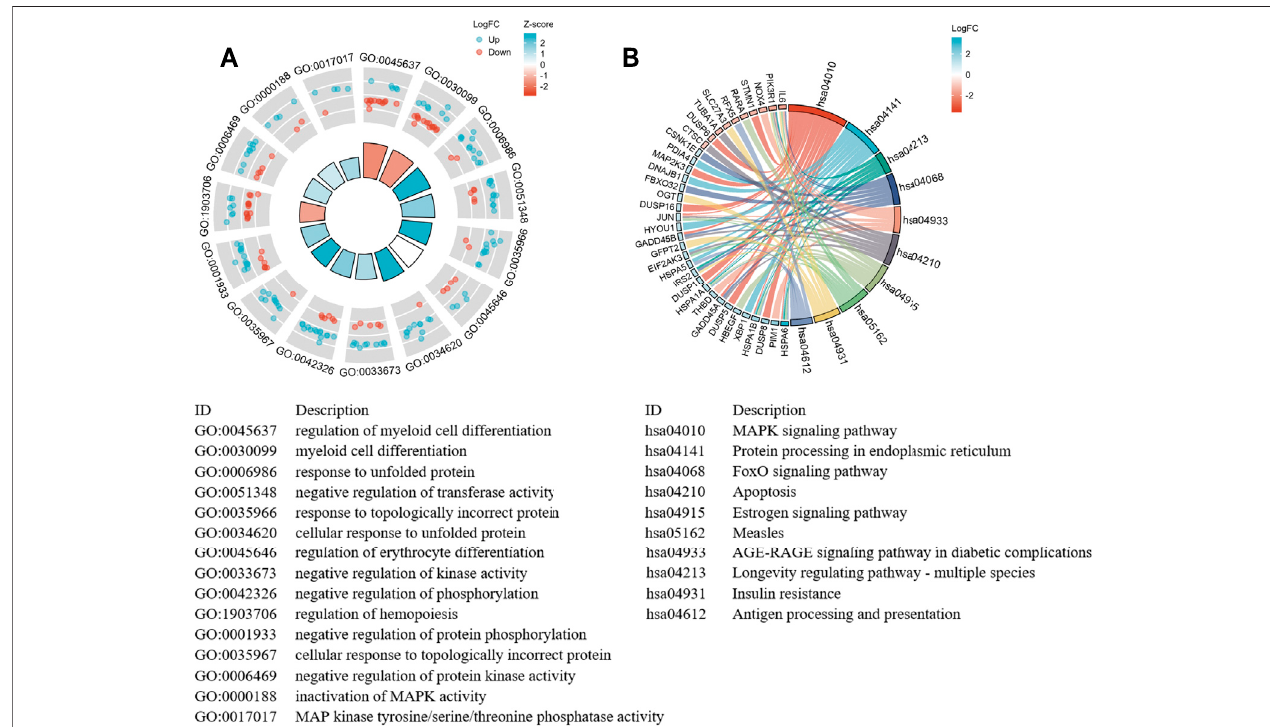
FIGURE 4 | The signi fi cant enrichment GO terms and KEGG pathways of the DEGs. (A) GO functional enrichment Circos plots of DEGs. Each column of the inner circle corresponds to a GO term. The height represents the adjusted p -value. The higher the column, the smaller the adjusted p -value. The fi lled color of the column representsthez-scorevaluecorrespondingtotheGOterms. (B) SignalingpathwaysenrichmentchorddiagramofDEGs.ThelefthalfrepresentstheDEGs,therighthalf shows thepathways, and thesizeofthecolorblockrepresentsthecorresponding counts. Thechordlines betweentheleft andright partsrepresentlinksbetween DEGs and specialized signaling pathways.